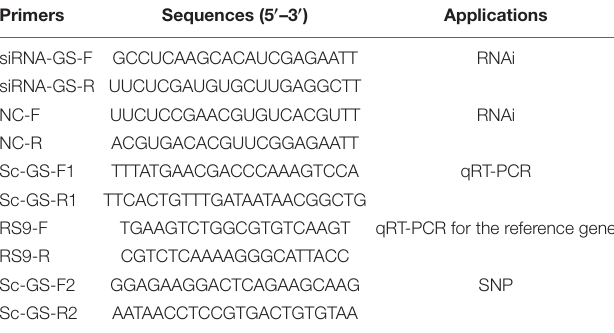
TABLE 1 | Primers and sequences of the experiments. Primers Sequences (5 (cid:48) –3 (cid:48) )